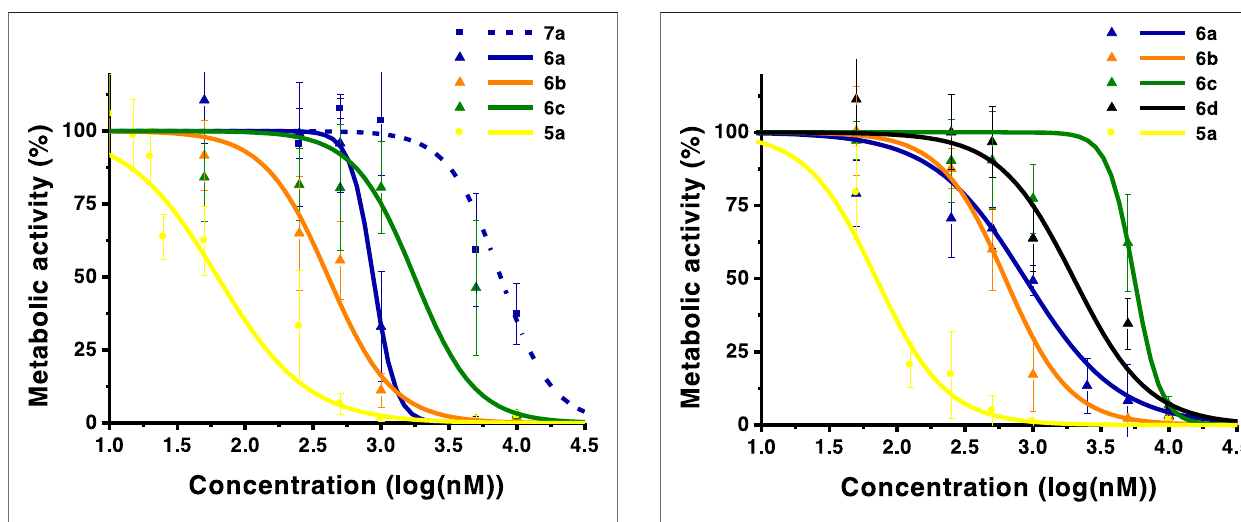
FIGURE 4 | Dose-response curves of HT1376 urinary bladder carcinomacells.Analysisperformed24 hafterPDT.Thegraphincludesdiacid chlorins 6a , 6b , 6c , and 6d , and dihydroxymethyl compound 5a . Data points represent the mean